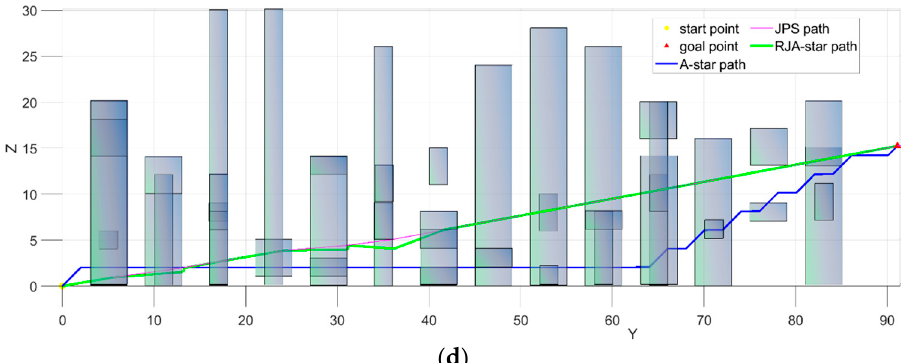
Figure 7. ( a ) The fitting results and details of RJA star algorithm on scenario 11. ( b ) Fitting result of XY plane of RJA star algorithm in scenario 11. ( c ) Fitting result of XZ plane of RJA star algorithm in scenario 11. ( d ) Fitting result of YZ plane of RJA star algorithm in scenario 11.